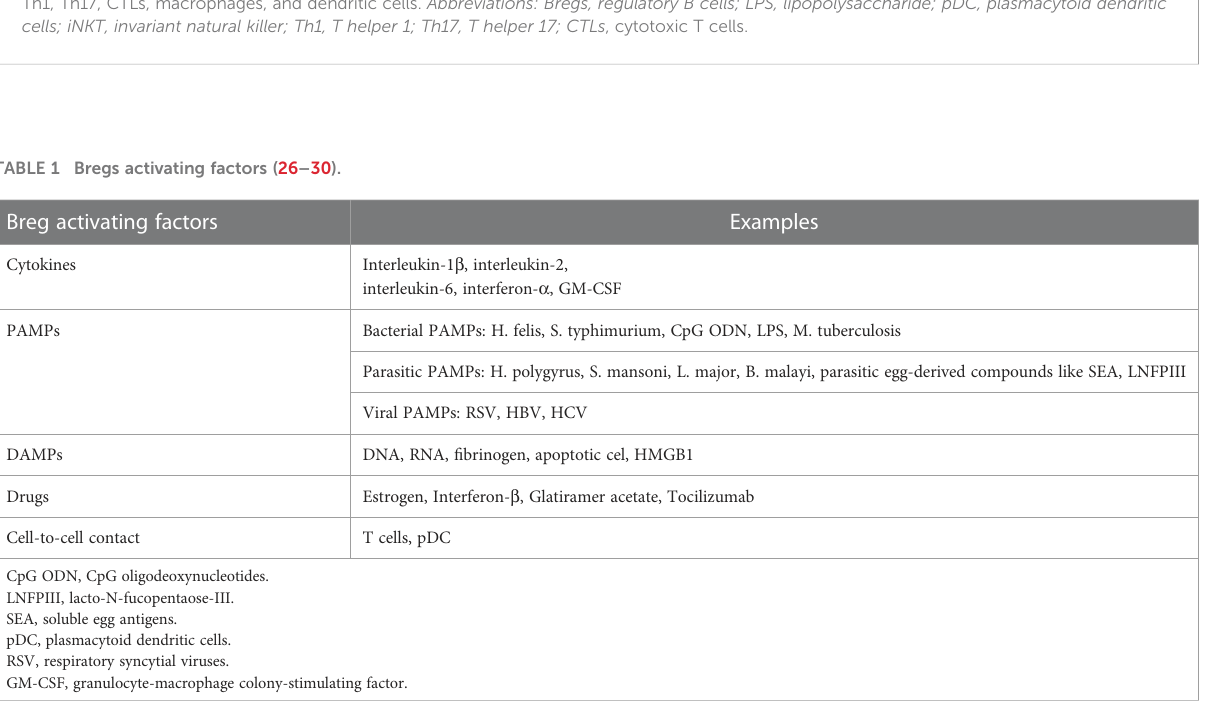
glucocorticoid-induced TNF- a -related receptor ligand (GITRL), programmed death-1 ligand (PD-L1), and Fas Ligand (FasL) (1,